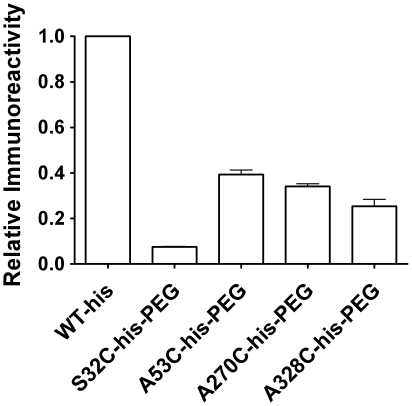
Immunoreactivity by ELISA.The antibody concentration required to achieve 50% maximum ELISA
signal (EC50) was determined for each enzyme using polyclonal
anti-A1-III antibody purified from rabbit immune serum. The results are
reported as fractional immunoreactivity based on normalization with the
WT-his enzyme, which was included as an internal control in all
experiments (see Experimental Procedures). All of the PEGylated enzymes
were found to exhibit significantly reduced antibody binding relative to
the WT-his control (p<0.01 for each). Error bars represent standard
deviation.